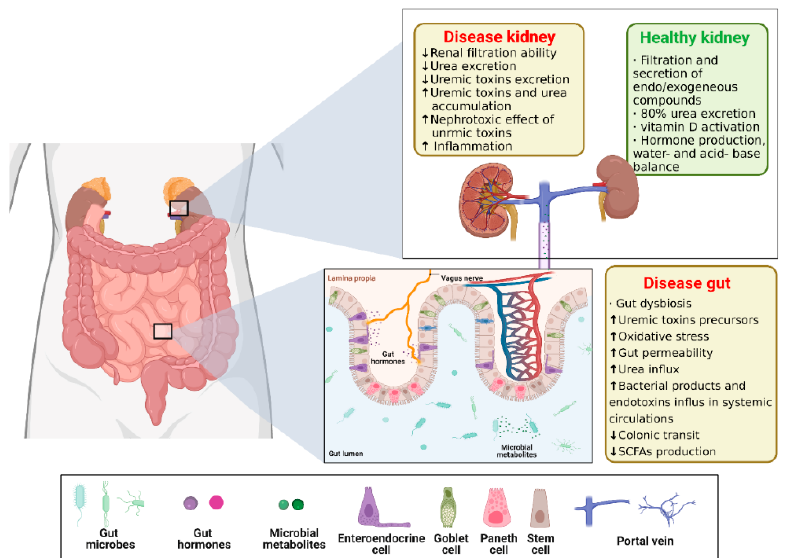
Figure 9. Schematics of Gut–kidney Axis (GKA). The gut luminal environment, including the gut microbiome, affects the physiology and behavior of the kidney via multiple routes. Created with BioRender.com. The ↑ and ↓ arrows in the graph represent an increase or decrease in content, performance, and/or activity, respectively. The reproduction of this image has been licensed from BioRender.